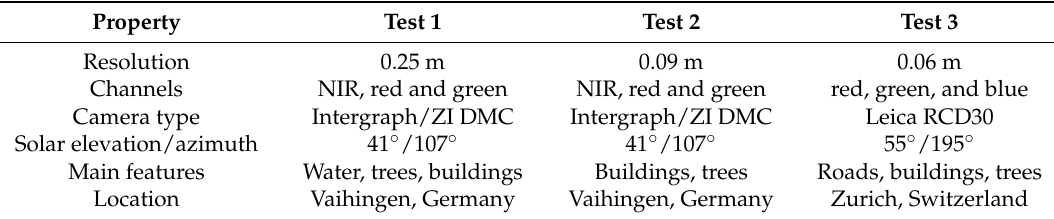
Table 2. The test